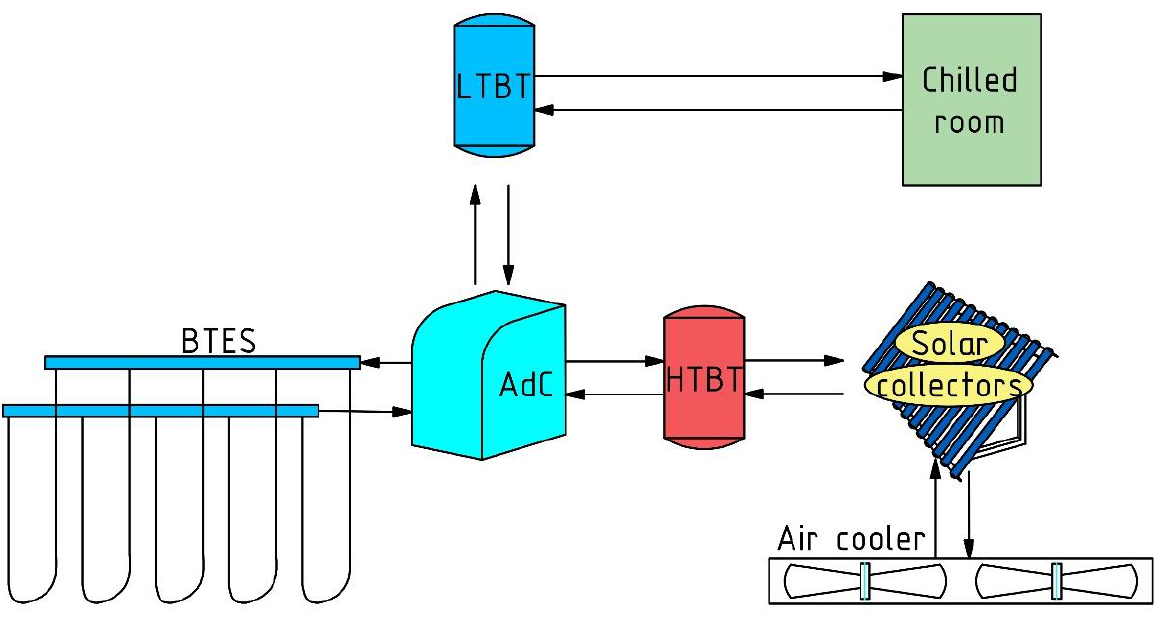
Figure 2. Diagram of the system: (AdC) adsorption chiller; (LTBT) low-temperature buffer tank; (HTBT) high-temperature buffer tank; (BTES) borehole thermal energy storage. Table 1. Technical data of SorTech eCoo 2.0 adsorption chiller [36].